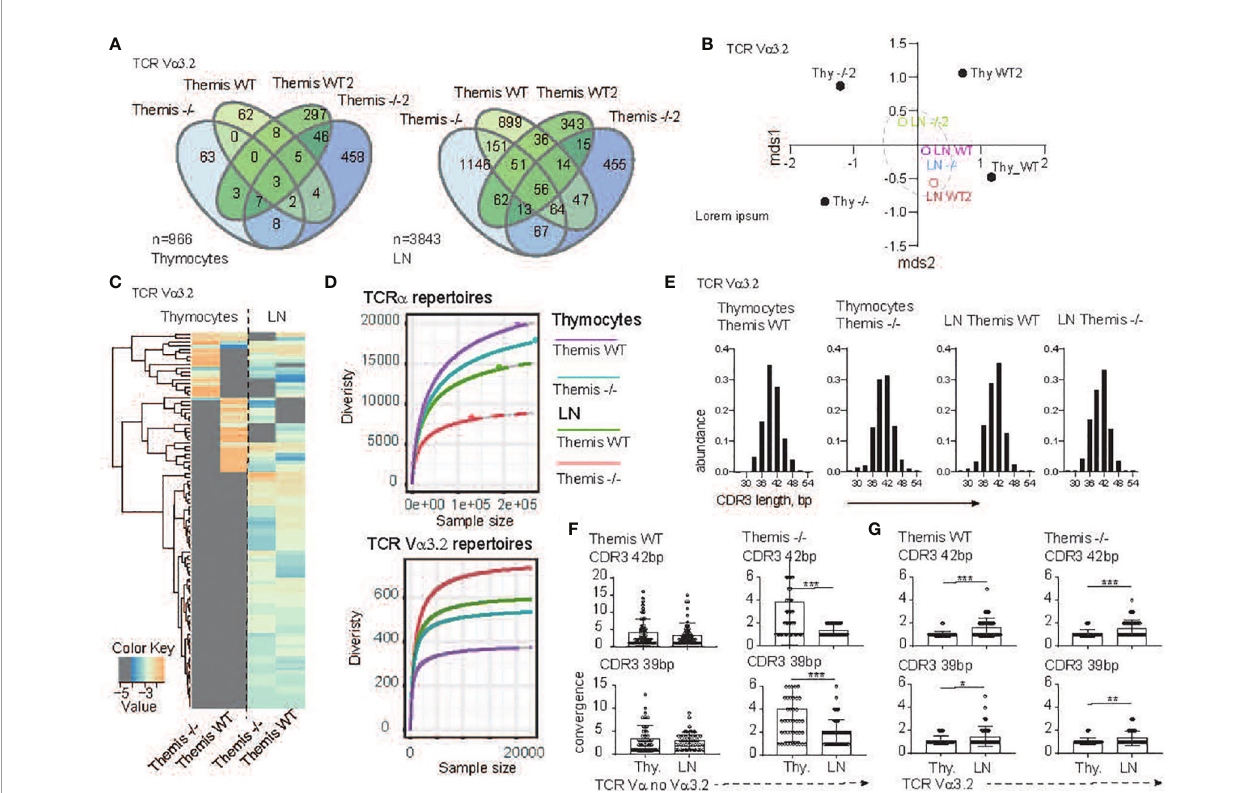
FIGURE 2 | TCR sequencing analysis of the CD8 compartment from Themis +/+ and Themis – / – mice. (A) The Venn diagram depicts distribution of the individual TCR V a 3.2 + clonotypes within SP CD8 + thymocytes (left) and CD8 + lymphocytes (right) in Themis +/+ and Themis – / – mice. n indicates total number of detected clonotypes. (B) Dendrogram and non-metric multidimensional scaling (mds1 and mds2) ordination plot of Themis +/+ and Themis – / – TCR V a 3.2 + repertoire similarity. (C) Heatmap represents abundance of the individual TCR V a 3.2 + clonotypes in the SP thymocytes and lymphocytes in Themis +/+ and Themis – / – mice. (D) The repertoire diversity within thymocytes and peripheral T cell subsets. Upper graph. Diversity was calculated in the context of the entire TCR a repertoires. Lower panel analysis was restricted to the TCR V a 3.2 + (TRAV9N-3) compartment. Rarefaction curves were plotted based on a multinomial model (53) and extrapolated to the largest sample. (E) In silico spectratyping of the CDR3 region of the TCR V a 3.2 + compartments. CD8 + T cell populations and genotype are indicated on the top of each graph. TCR convergence estimated in the 50 most dominant clones with (F) non V a 3.2 and (G) V a 3.2 + TCRs representing 39 or 42 bp CDR3 lengths, respectively. TCR compartment, population and genotypes are indicated on the graphs. In all fi gures, data for each genotype were pooled from two individual experiments. Data were considered statistically signi fi cant when *p < 0.05, **p < 0.01, ***p < 0.001 as determined by for two-sided Student ’ s t-test with Welch ’ s